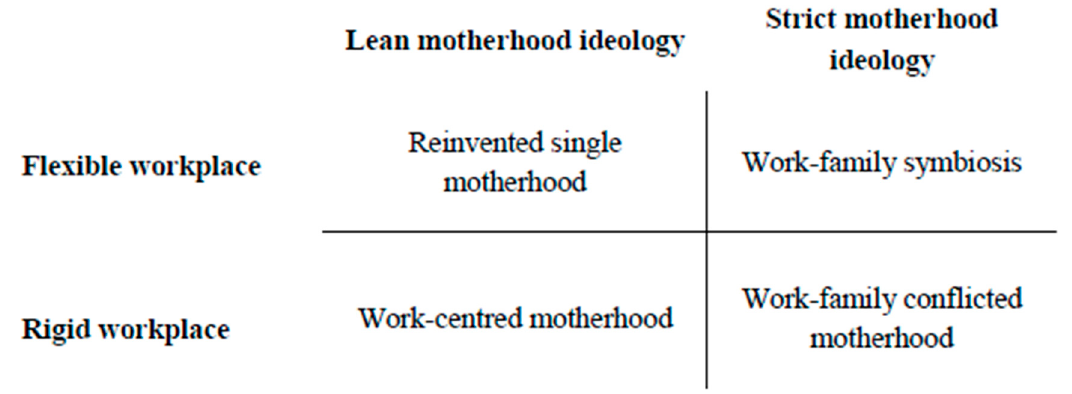
Figure 1. Perspectives on the combination of motherhood and work.